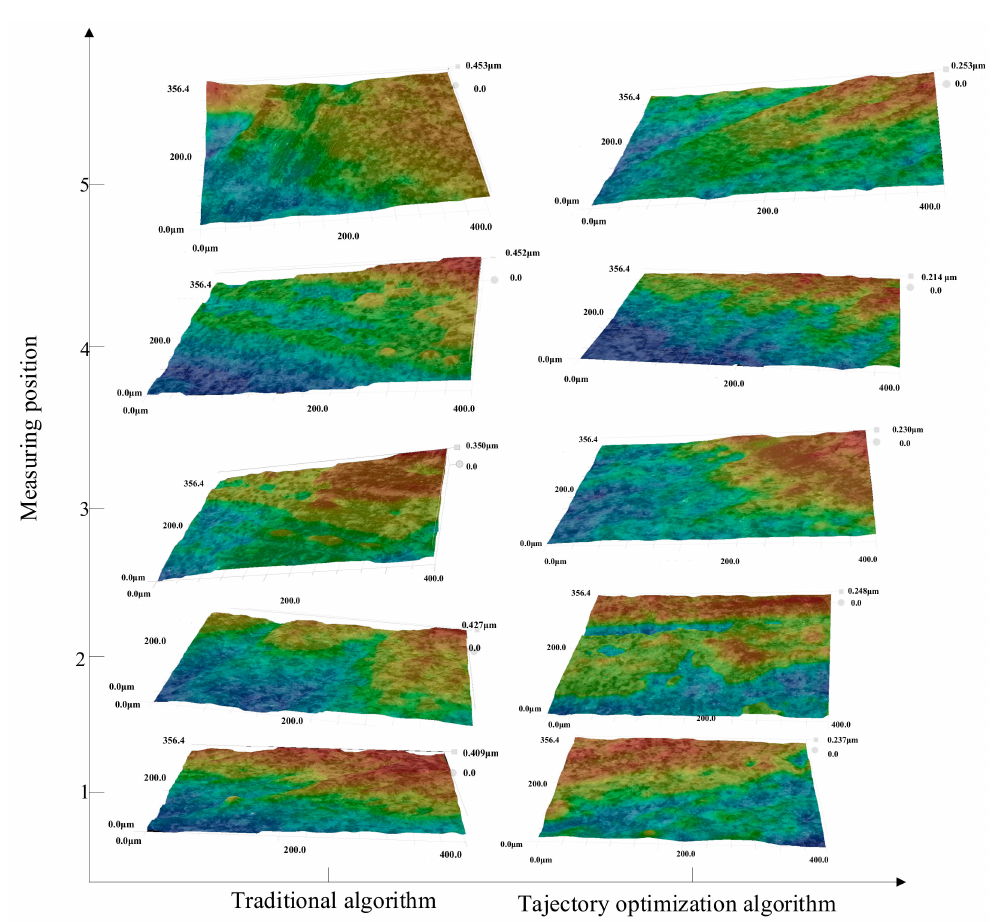
Figure 22. Superdepth three-dimensional topography of the five regions under two